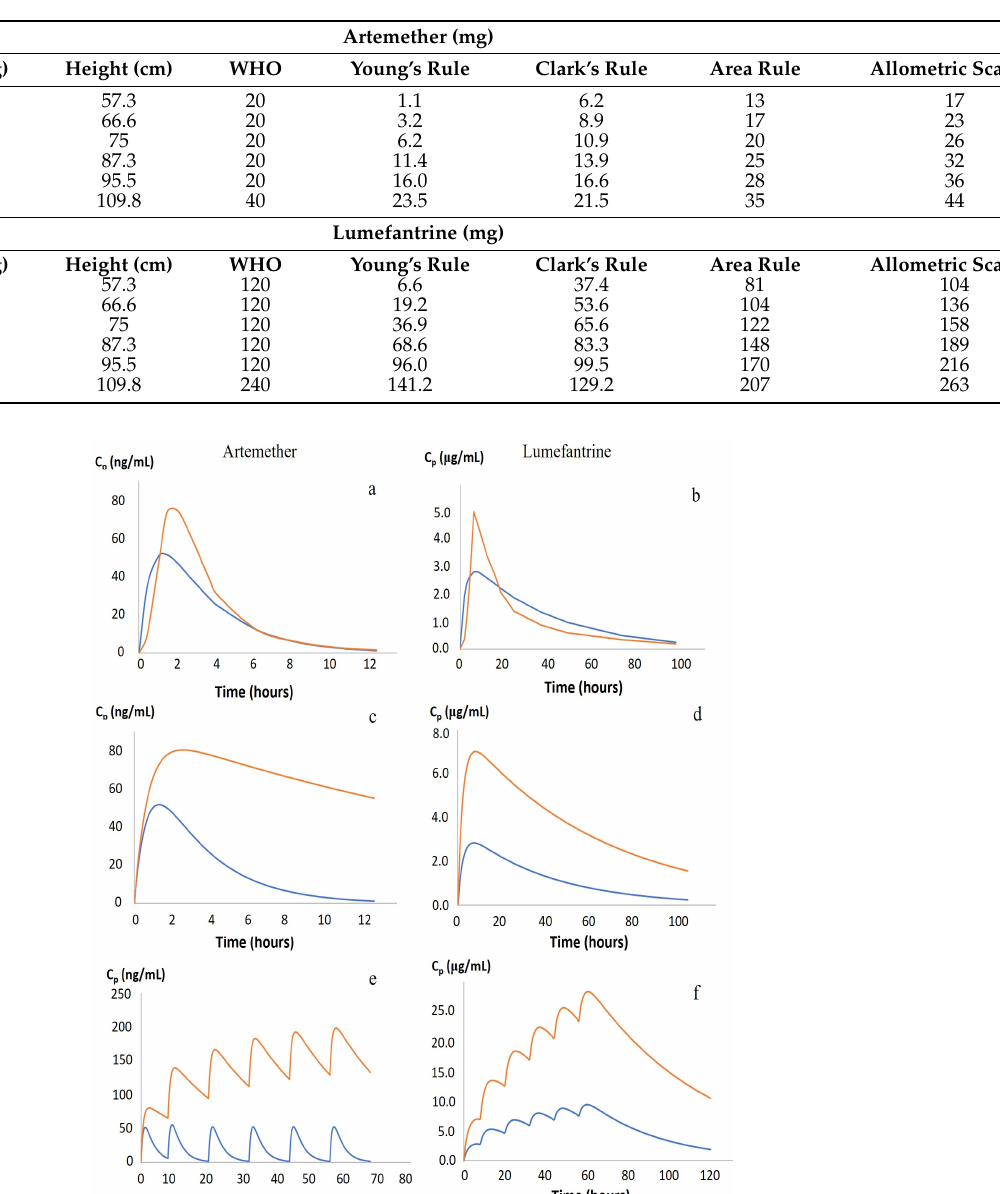
Table 4. Calculated dosages for children, at different ages, using various published methods to extrapolate from adult dose to pediatric dose, compared to WHO recommendations for the same age.